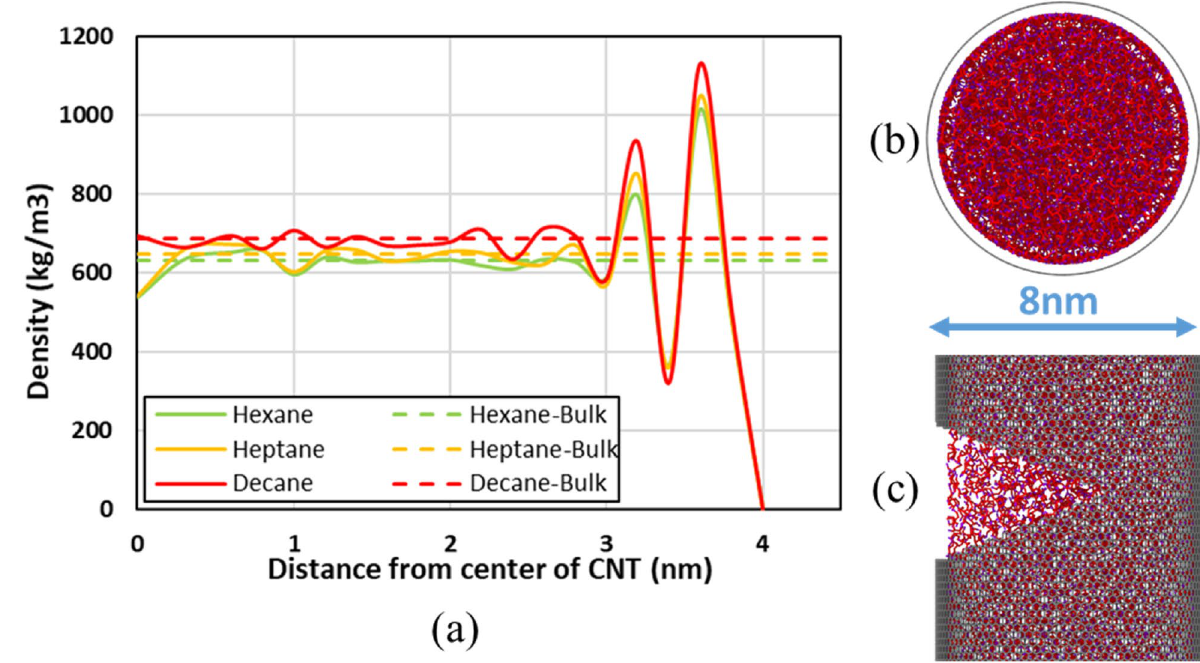
Figure 3. ( a ) Effect of confinement on the cross-sectional local density of fluids under confinement compared to the bulk density for 8 nm diameter CNT at 1 atm, ( b ) cross-section of decane (carbon chain only) in 8 nm CNT, and ( c ) side view of decane (carbon chain only) in 8 nm CNT. Red represents carbon, and Purple represents terminal carbon for the given Decane molecule. A small slit is cut into the CNT to observe the arrangement of hydrocarbon inside. Created using OVITO